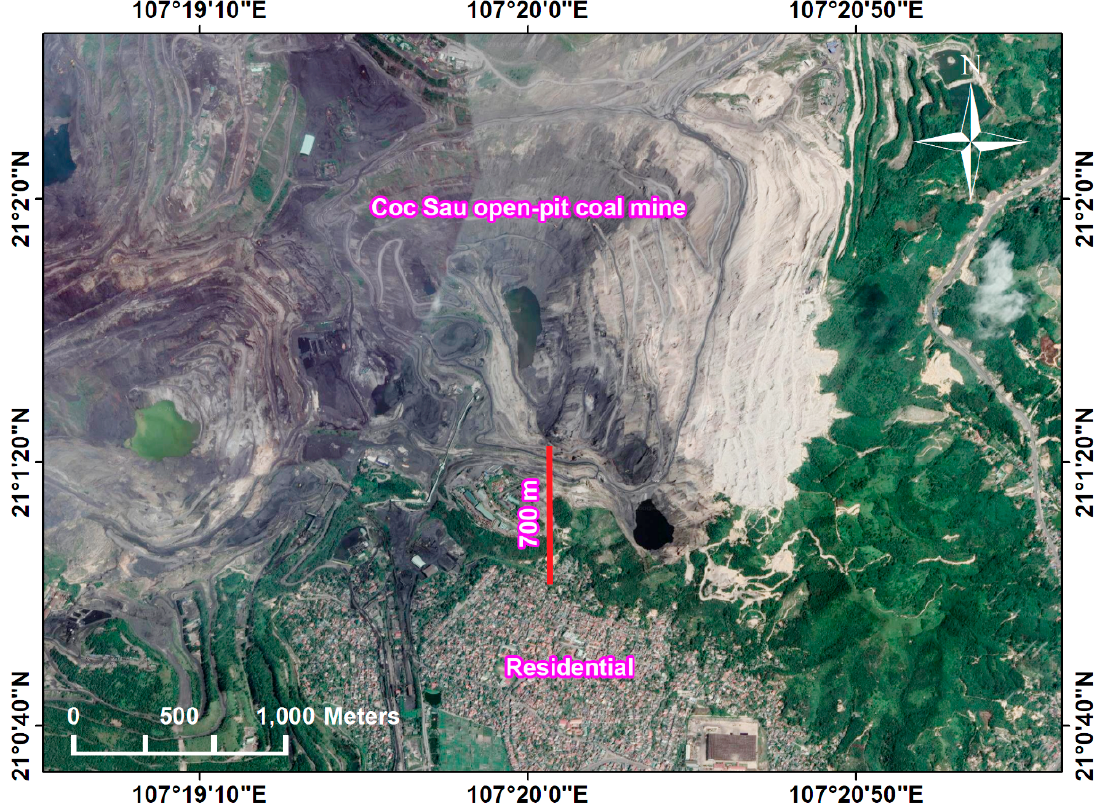
Figure 3. The distance from the mine to the residential area.